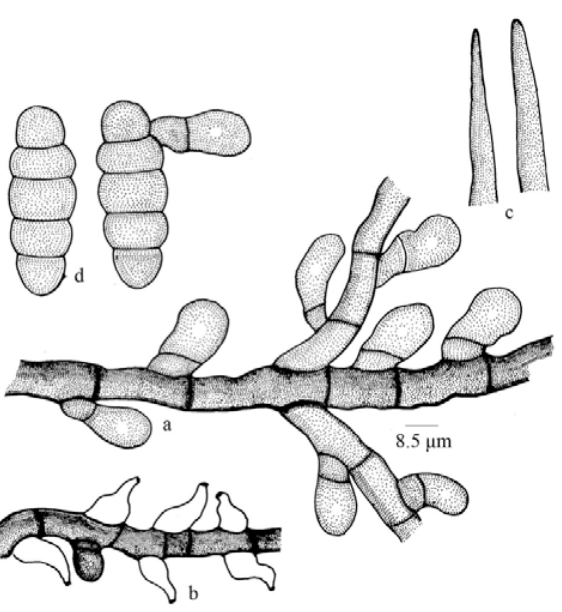
Figure 107. Meliola phyllanthigena a - Appressorium; b - Phialide; c - Apical portion of mycelial setae; d -